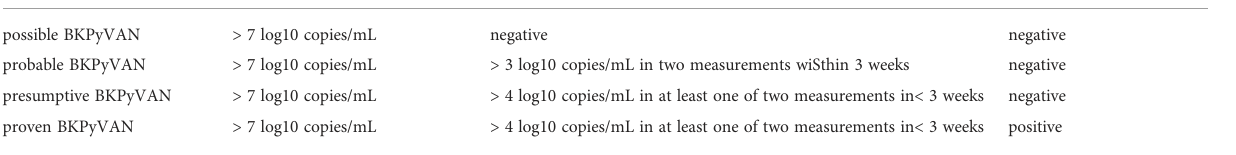
TABLE 1 BKPyVAN diagnostic